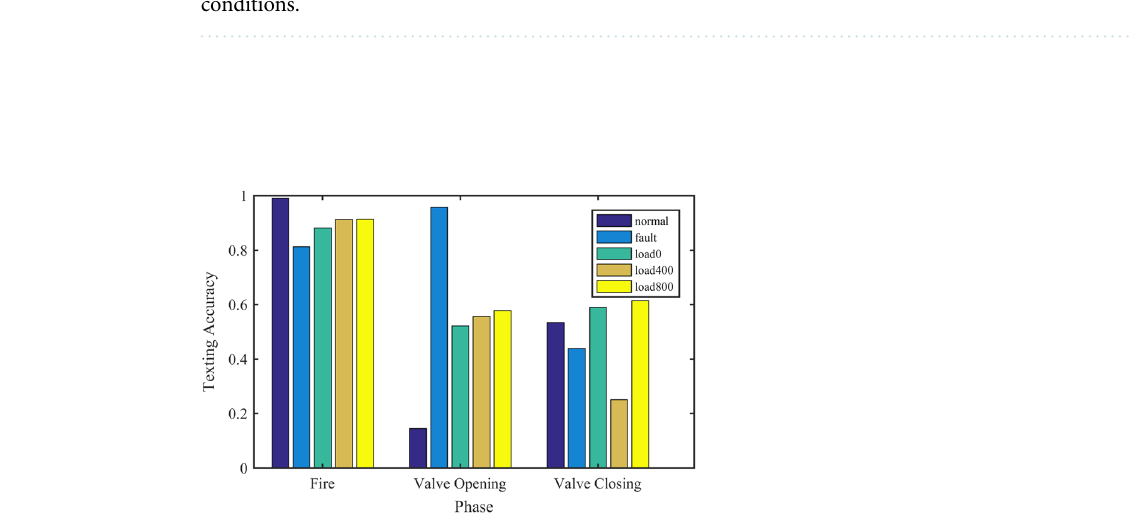
Figure 9. Visualization of attention weight on envelope spectrum signal (8000 Hz) of various working conditions.